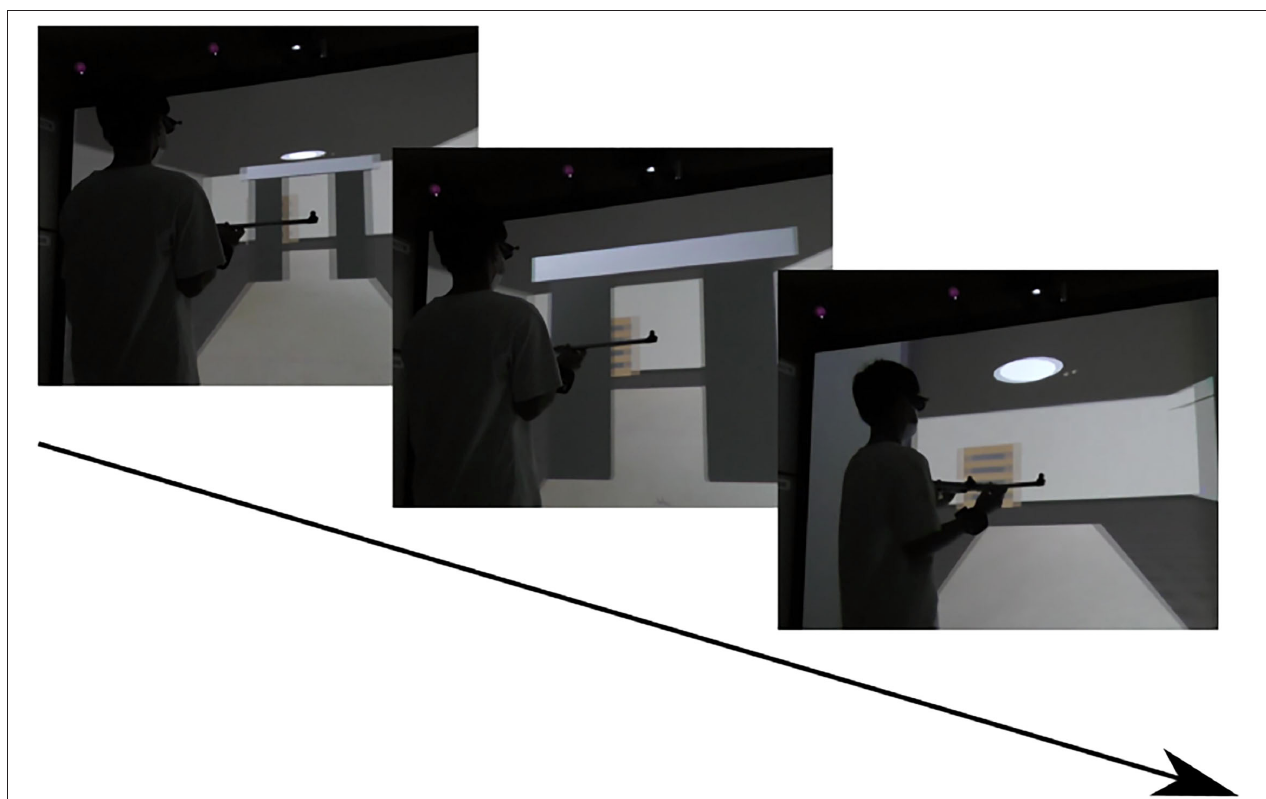
FIGURE 4 | VR environment for